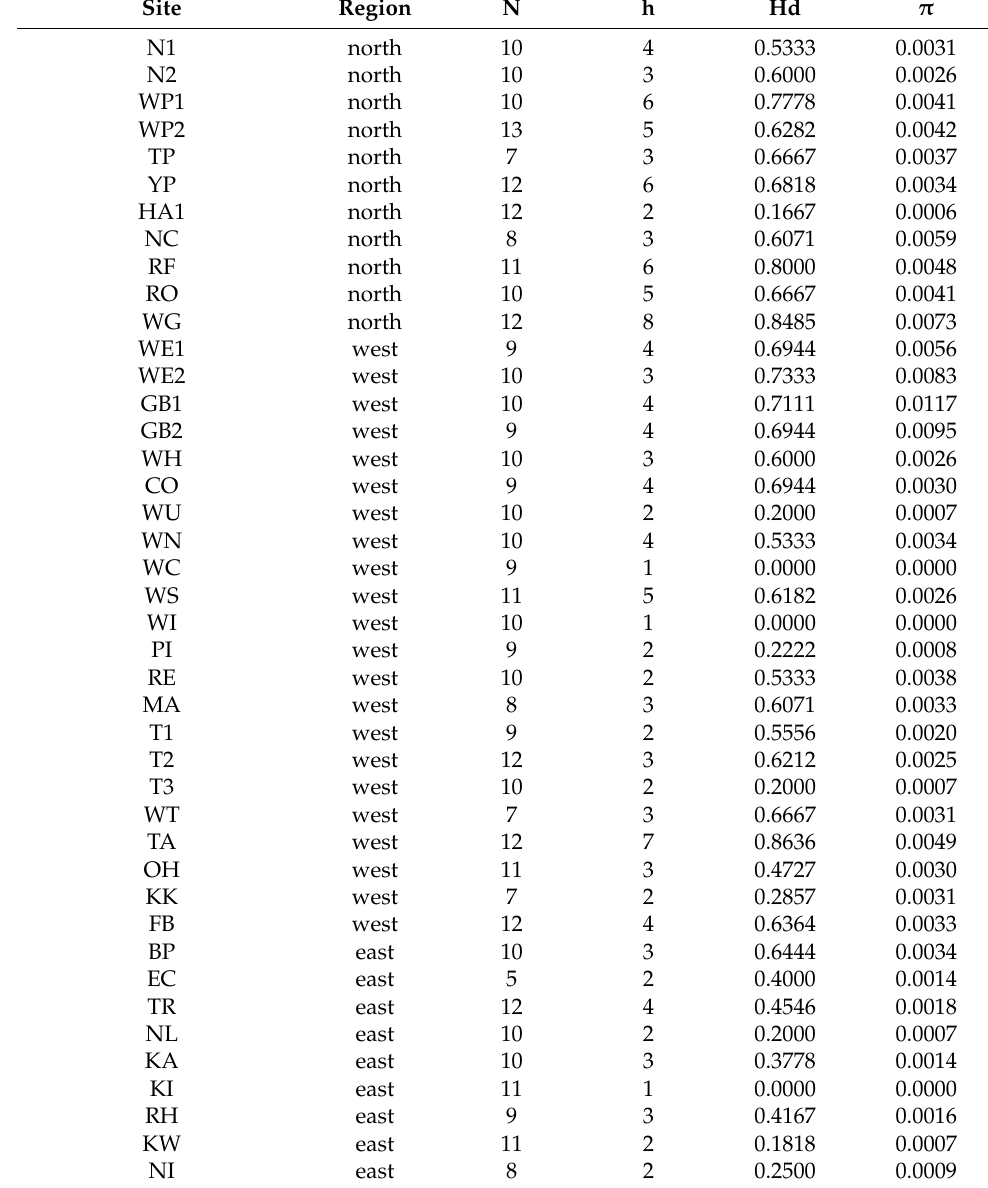
Table 2. Summary of variation among partial mtDNA cytochrome-b haplotypes for population samples of the New Zealand mayfly Acanthophlebia cruentata , ordered by region ( π , nucleotide diversity; h, number of haplotypes; Hd, haplotype